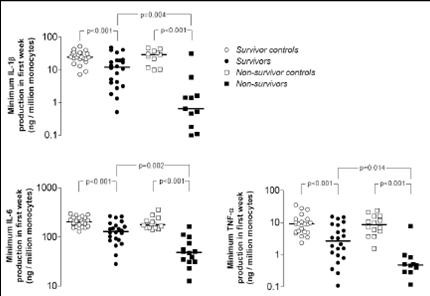
Minimum LPS-stimulated cytokine production in first week in survivors and non-survivors to 12 months. P values generated from analysis of log-transformed data (logistic regression for comparison of survivors and non-survivors, paired t-test for comparisons with controls).